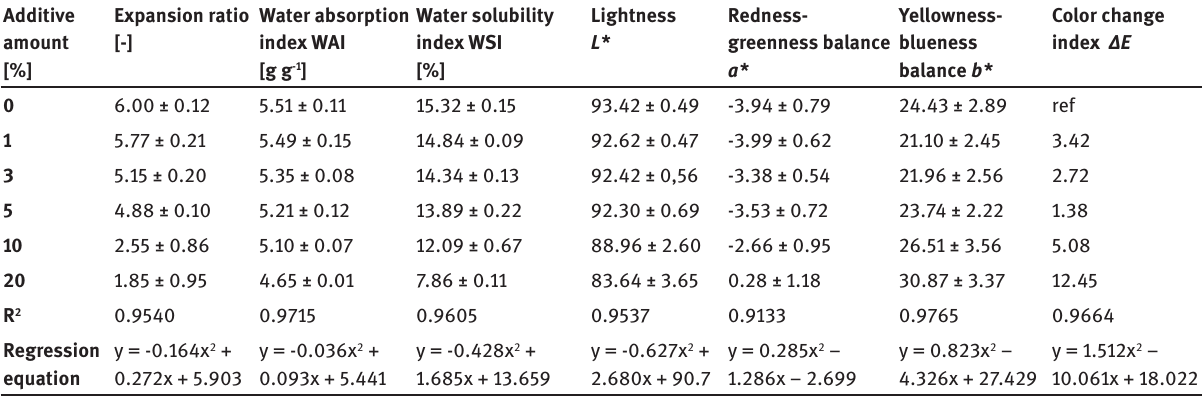
Regression equation